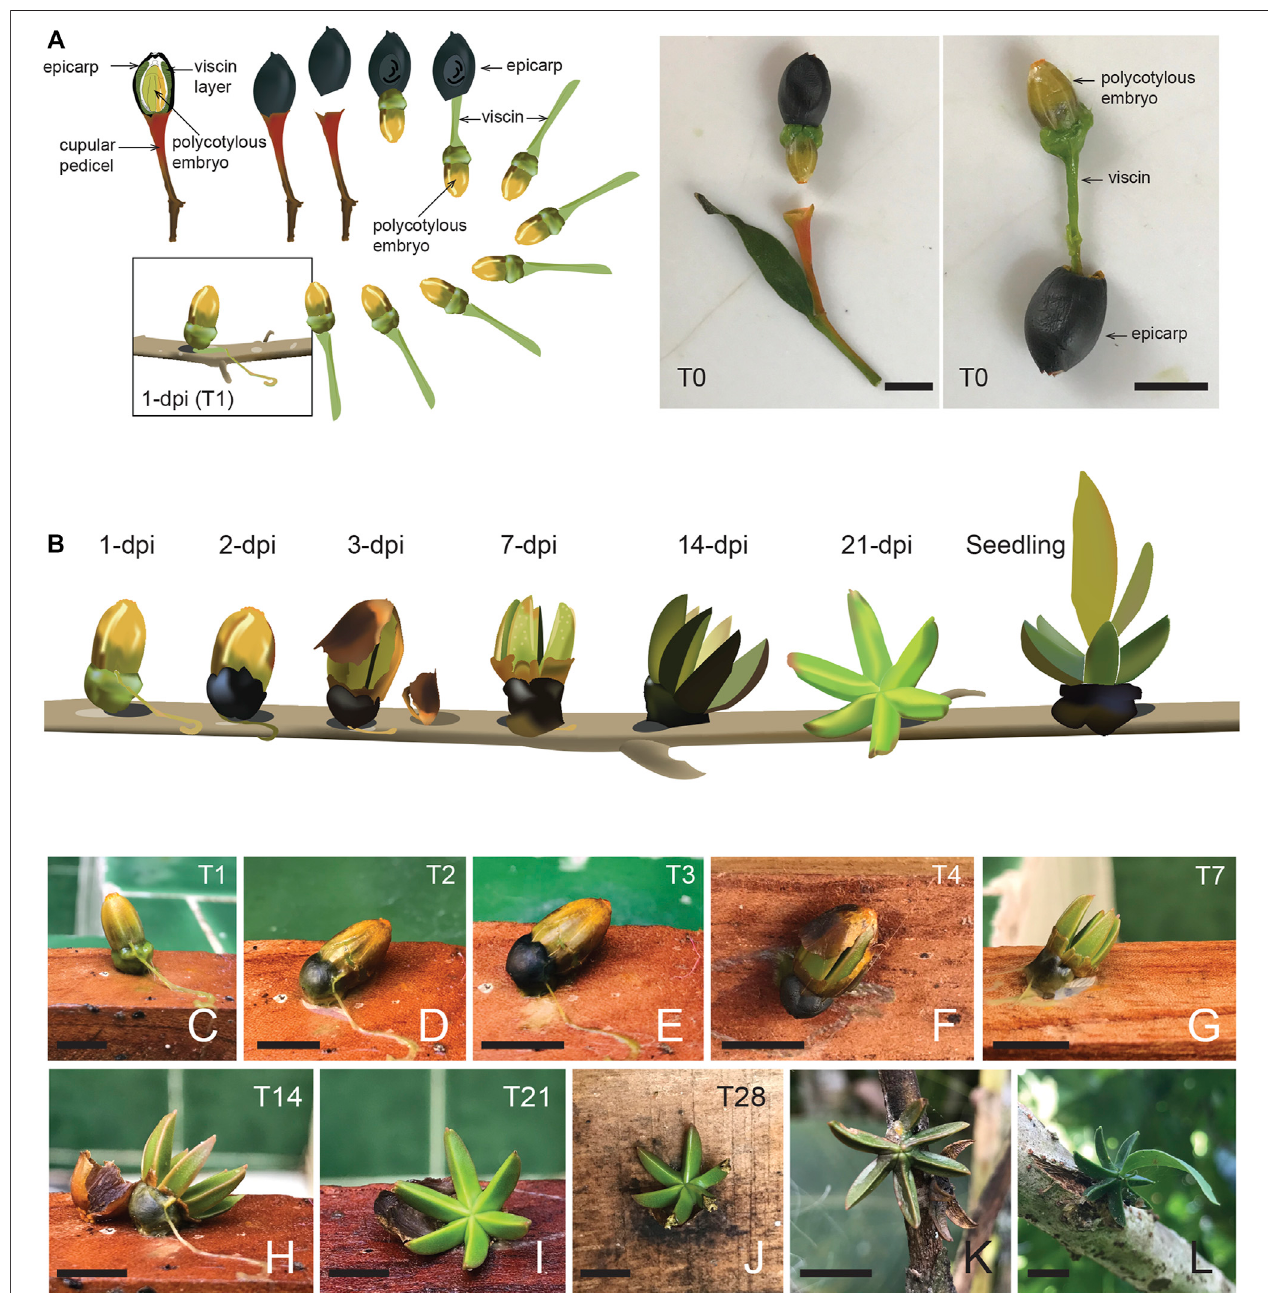
FIGURE 1 | The Psittacanthus schiedeanus mistletoe seed inoculation experiment. (A) One-seeded ripe fruits had their epicarp manually removed, and seeds collectedwerethenplaced andglued withtheirviscinonwooden rectangle sticks(30 – 50 cmlong)and placedat 5 cmfromeach other. Images showemergingembryo when manually pushed out before being placed on the wooden rectangle sticks aided by the green viscin and an extracted embryo with viscin at the base and epicarp removed. Theseare referred in the text aspre-inoculation, pre-sproutingseeds(time 0; T0). Morphology and anatomy ofthe infructescence and fruitare illustrated in Supplementary Figure S1 . (B) Illustration of different development stages of inoculated seeds after 1 – 28 days after inoculation/germination (dai/dag) based on photographs. The plant material used for the RNA-seq study consisted of chlorophyllous material from the manually extracted seeds (T0), as illustrated in (A) and from four different development stages of the seeds formed by the polycotylous embryo (T1 – T4: 7, 14, 21, and 28 dai/dag. (C – F) Images of inoculated seeds placed on the wooden rectangle sticks, from one to 4 days after inoculation/germination (T1 – T4). Note how the viscin dries out, the base of the embryo becomes black (the scar-like dark-area that potentially includes the suspensor that is pushed aside by the emerging haustorial organ, which is not morphologically terminal, but it develops from the fl anks of the apical dome; (Kuijt, 1970; Kuijt, 2009) and the embryo ’ s envelope or seed cover breaks about the middle after 4 days of seed inoculation. (G – J) Images of seeds after 7 (T7), 14 (T14), 21 (T21) and 28 (T28) dai/dag, with samplings taken for the RNA-seq study from T0, T1 – T4, T7, T14, T21 and T28. After seven dai/dag the polycotylous embryo starts opening by day 7 (cotyledons spread) and becomes fully open by day 21. After 28 dai/dag, the prismatic lobes (6 – 7 cotyledons) of the star-